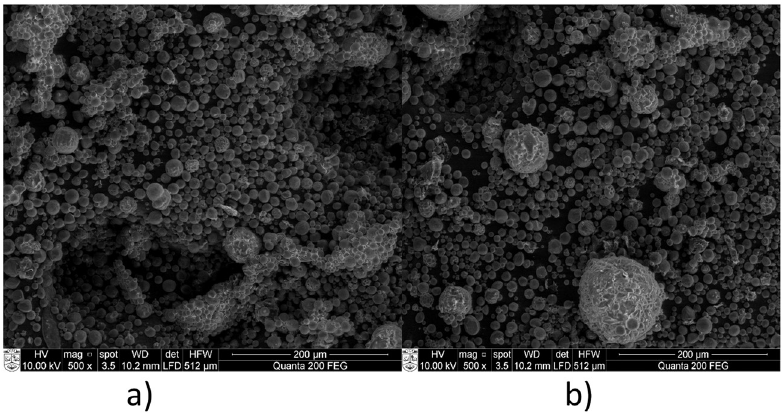
Figure 4: SEM micrograph of microcapsules ( PLA/CA ( a ) and PLA/CA + C ( b ))